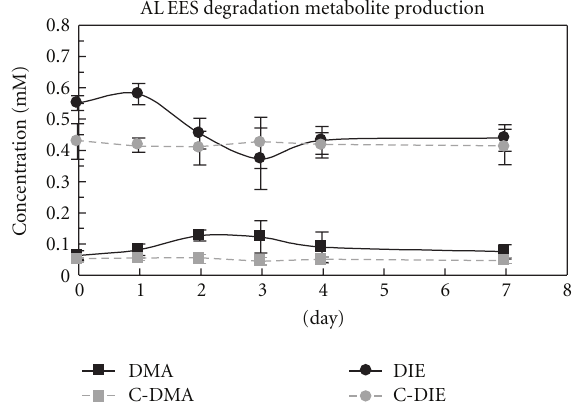
Figure 7: Production of alachlor metabolites over time in the EES degradation study. Numbers are the average of 9 values. Error bars represent one standard deviation of triplicate